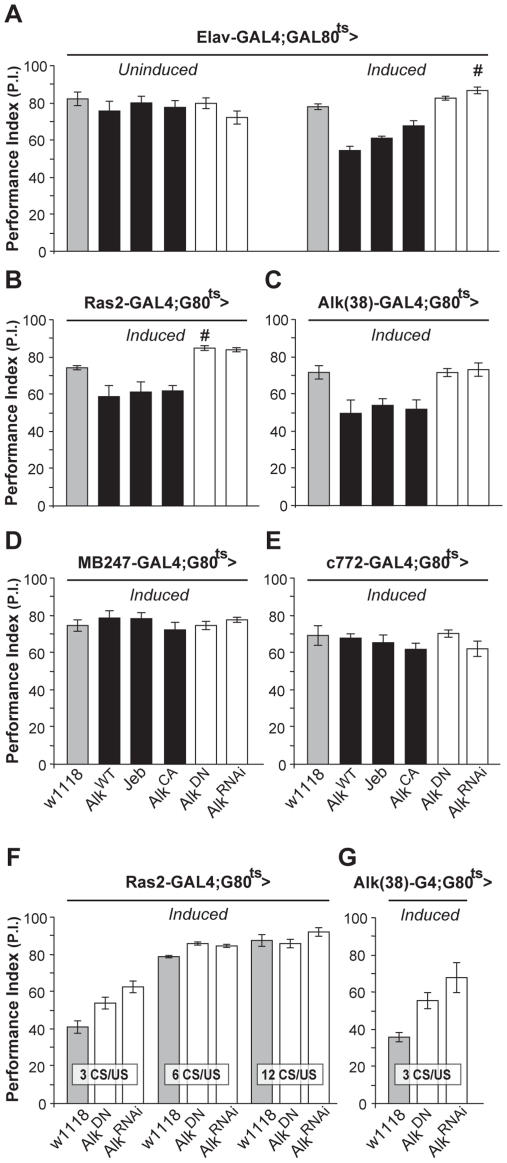
dAlk activity in adult neurons negatively regulates olfactory learning.Mean Performance Indexes ± SEMs are shown after olfactory training with 6 CS/US pairings, unless indicated otherwise. (A) Flies carrying, but not expressing UAS-dAlk transgenes (‘Uninduced’) performed equally well with controls (F(5,40) = 0.94, p>0.46, n≥6 for all genotypes). Pan-neuronal transgene expression (‘Induced’) affected learning, as indicated by ANOVA (F(5,41) = 23.72, p<0.0001, n≥6). Pairwise comparisons demonstrated highly significant differences in the performance of animals expressing AlkWT, Jeb and AlkCA compared to heterozygous driver carrying control flies (w1118). (B and C) dAlk manipulations also affected learning in Ras2-Gal4 and Alk(38)-Gal4 expressing neurons (ANOVA F(5,45) = 16.8, p<0.0001, n≥6 and F(5,36) = 7.142, p<0.0002, n = 6 respectively). Highly significant differences in the performance of AlkWT, Jeb and AlkCA-expressing animals were documented in comparison to control flies. (D and E) Expression of dAlk transgenes within the MB using MB247 and c772 drivers did not affect learning (F(5,42)  = 0.70, p>0.62, n≥6 for MB247 and F(5,45) = 1, p>0.42, n≥7 for c772). Significantly enhanced learning relative to controls upon abrogation of dAlk activity is denoted by (#). (F) Characterization of the learning enhancement phenotype upon down-regulation of dAlk signaling in Ras2-expressing cells. Significant effects of genotype were found after less intense training conditions (3 and 6 CS/US pairings) but not after 12 CS/US training, indicating a plateau effect (ANOVA F(2,20) = 12.15, p<0.0005, F(2,22) = 27.35, p<0.0001, F(2,20)  = 1.38, p>0.27 for 3 CS/US, 6 CS/US and 12 CS/US respectively, n = 6–8 for all genotypes). Planned pairwise comparisons indicated significant differences between controls and flies with down-regulated dAlk when trained with 3 CS/US pairings (p<0.0001 and p<0.013 for UAS-AlkRNAi and UAS-AlkDN, respectively) and 6 CS/US pairings (p<0.0001 for UAS-AlkRNAi and UAS-AlkDN). (G) Down-regulation of dAlk in otherwise wild type cells enhanced learning performance under low training conditions with 3 CS/US pairings. ANOVA indicated significant effects of genotype (F(2,16) = 8.09, p<0.0052, n>5). Planned pairwise comparisons indicated significant differences between controls and flies with down-regulated dAlk signaling in Alk-expressing cells (p<0.0016 and p<0.02 for UAS-AlkRNAi and UAS-AlkDN, respectively).